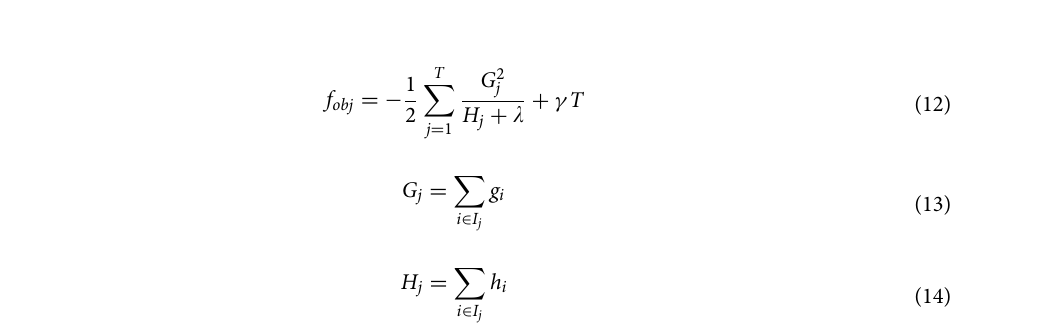
Figure 4. The ridge trace diagram of all input variables, where the dependent variable is the O 3 concentration measured by the national control